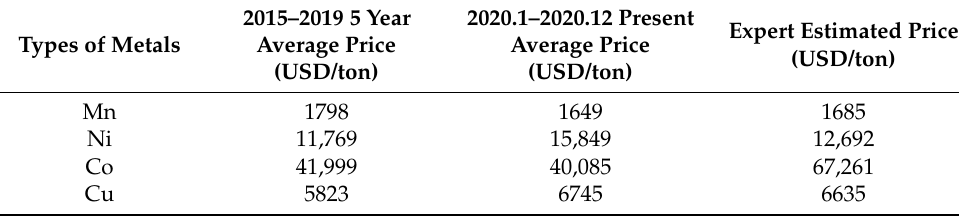
Table 9. Three sets of metal prices were used in the